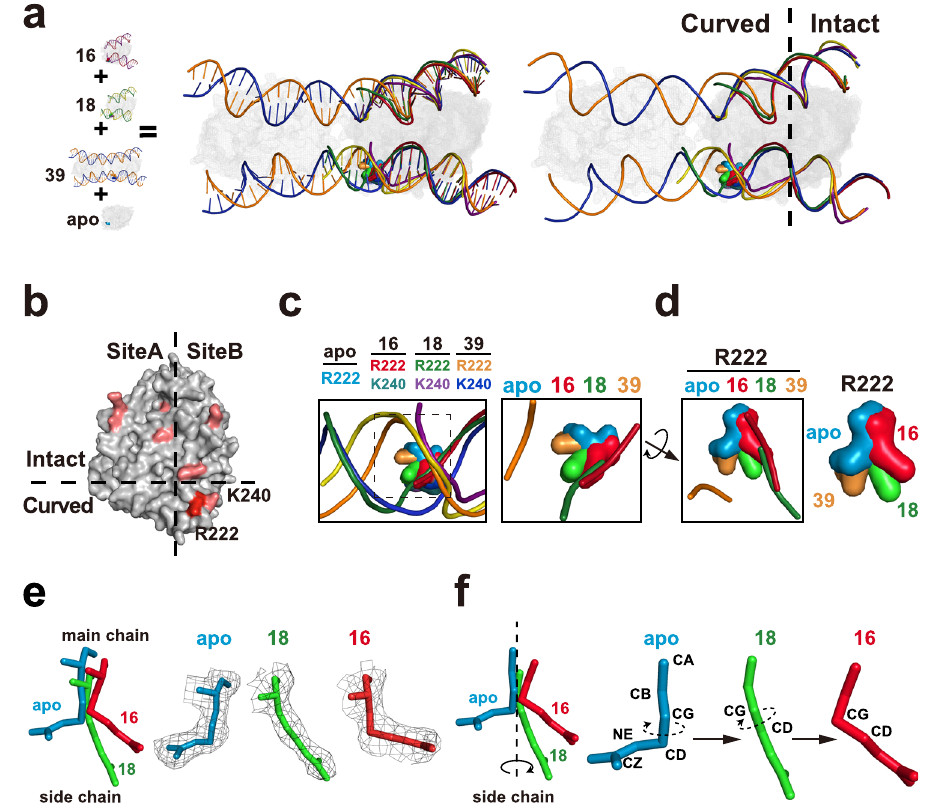
Fig. 6 | Structural analyses suggest that R222 might detect DNA-curving to sense fl exibility.a Left:Superpositionofapo-,16-,18-and39bpDNA – cGASatomic models visualized by PyMOL. The K240-binding single-strand (Kbss) of DNA and the strand complementary to K240-binding single-strand (sc – Kbss) are shown by ribbon representations. The cGAS proteins are shown by mesh representations. Unless speci fi cally noted, R222 residue binds to the corresponding DNA single- strand marked by the same color. For instance, R222 (red) residue binds sc – Kbss (red) in 16bp atomic model. Right: The main chains of DNAs are shown by ribbon representations, while the side chains of DNAs are hided. Apo: R222: light blue. 16 (16bp complex): R222: red; K240:dark green; Kbss: red;sc – Kbss: purple. 18:R222: green; K240: purple; Kbss: green; sc – Kbss: yellow. 39: R222: orange; K240: blue; Kbss:blue;sc – Kbss:orange. b Surfacestructureshowingthelocationofconserved DNA-binding residues. c Enlargedsuperposition of the notedatomicmodelsin( a ). ThemainchainsofDNAareshownbyribbonrepresentations,whilethesidechains